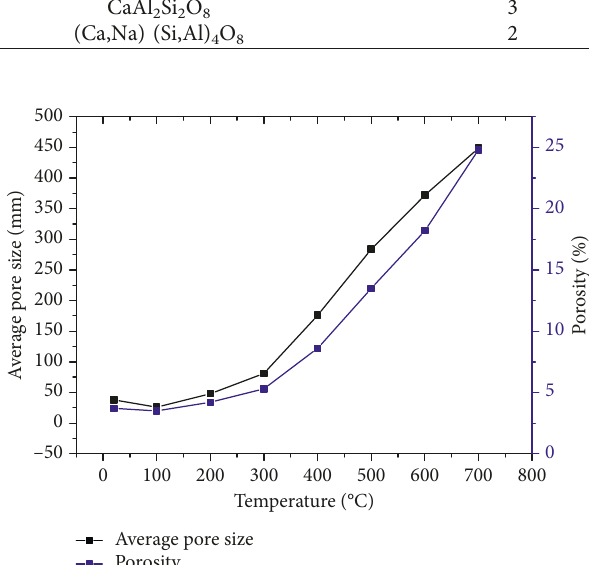
Figure 9: The relationship between average pore size and porosity of sandstone and